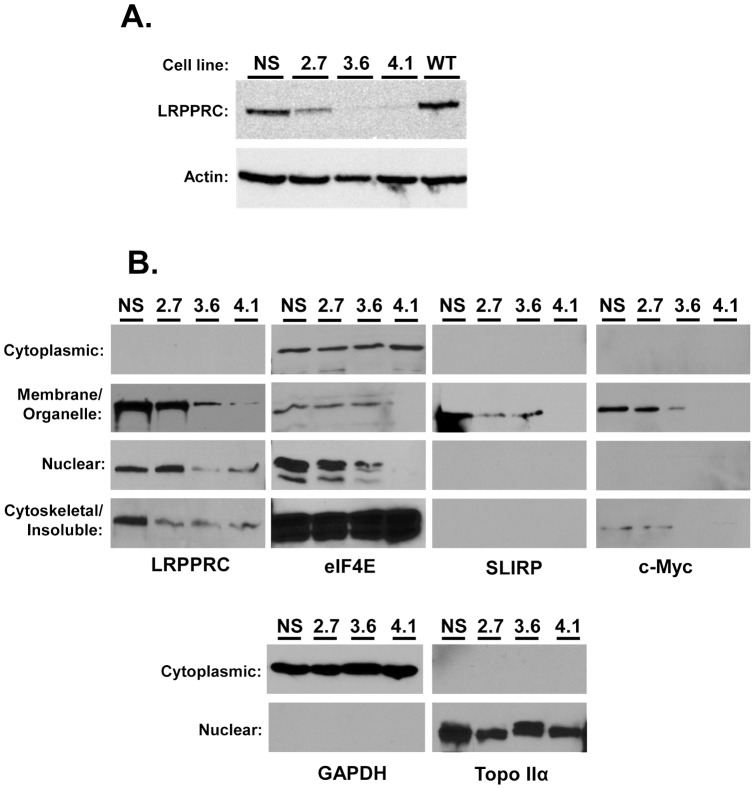
Stable knockdown of LRPPRC alters the subcellular localization of several proteins.(A) Level of LRPPRC knockdown in 293T cells stably transfected with the indicated LRPPRC-specific shRNAs. Knockdown was determined by comparing LRPPRC expression (top panel) to actin expression (bottom panel). WT shows the parental 293T cell line. (B) Subcellular fractionation of the shLRPPRC cell lines. The indicated cell lines were fractionated into cytoplasmic, membrane/organelle, nuclear, and insoluble/cytoskeletal fractions and LRPPRC, eIF4E, SLIRP, and c-Myc expression were determined by Western blot. GAPDH and Topoisomerase IIα (lower panel) were detected to ensure proper cell fractionation. Data is representative of 3 independent experiments.